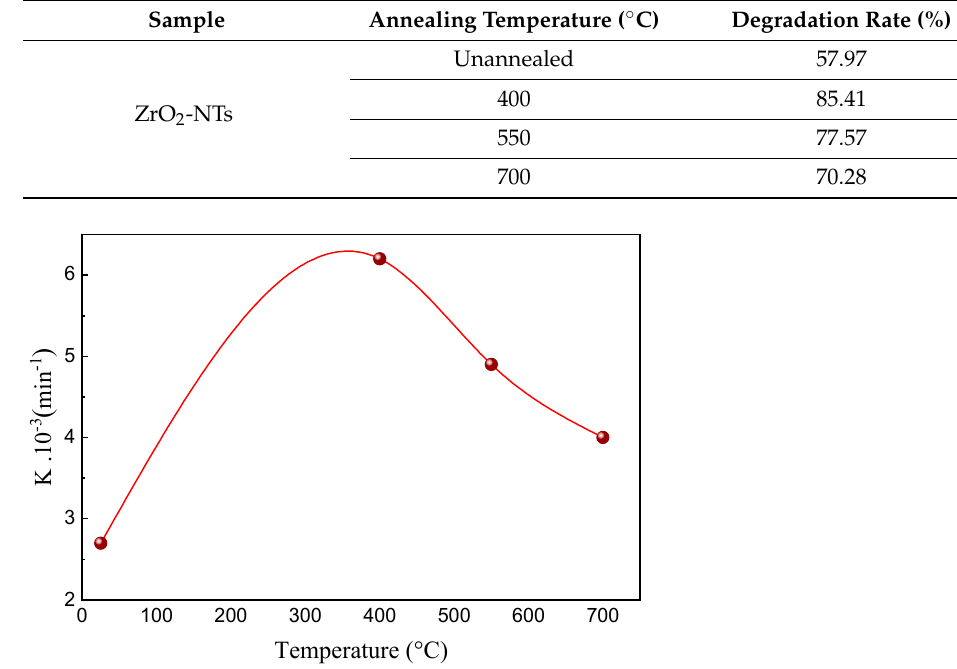
Table 3. Photocatalytic performance of ZrO 2 NTs as a function of the annealing temperature.